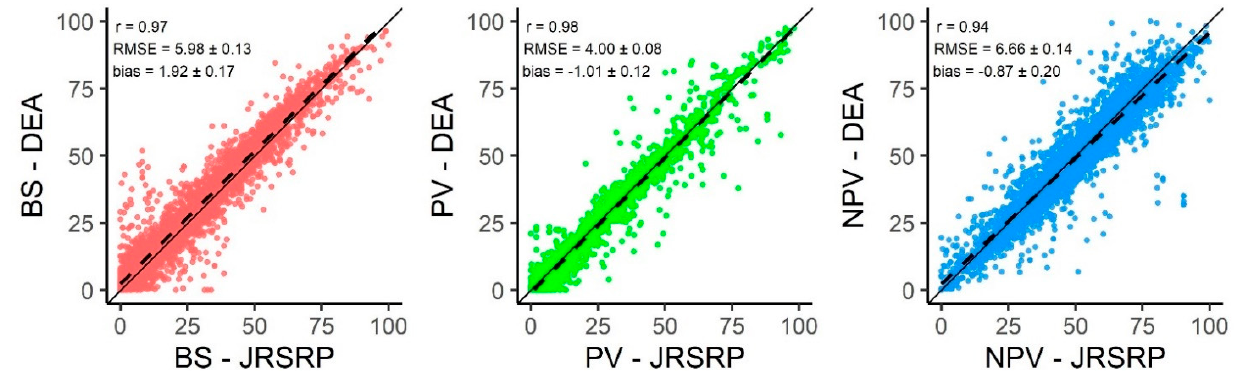
Figure 4. Scatterplots showing JSRSP (x-axis) and DEA (y-axis) estimated fractions (%) of bare soil ( left ), photosynthetic vegetation ( middle ) and non-photosynthetic vegetation ( right ) for 4166 field sites. The black line represents the 1:1 agreement, the dashed line is the linear fit between both estimations.